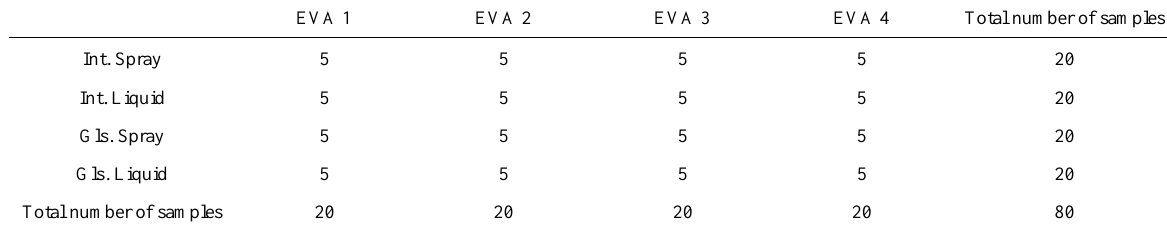
Table 3: Matrix for the desired samples of shear tests